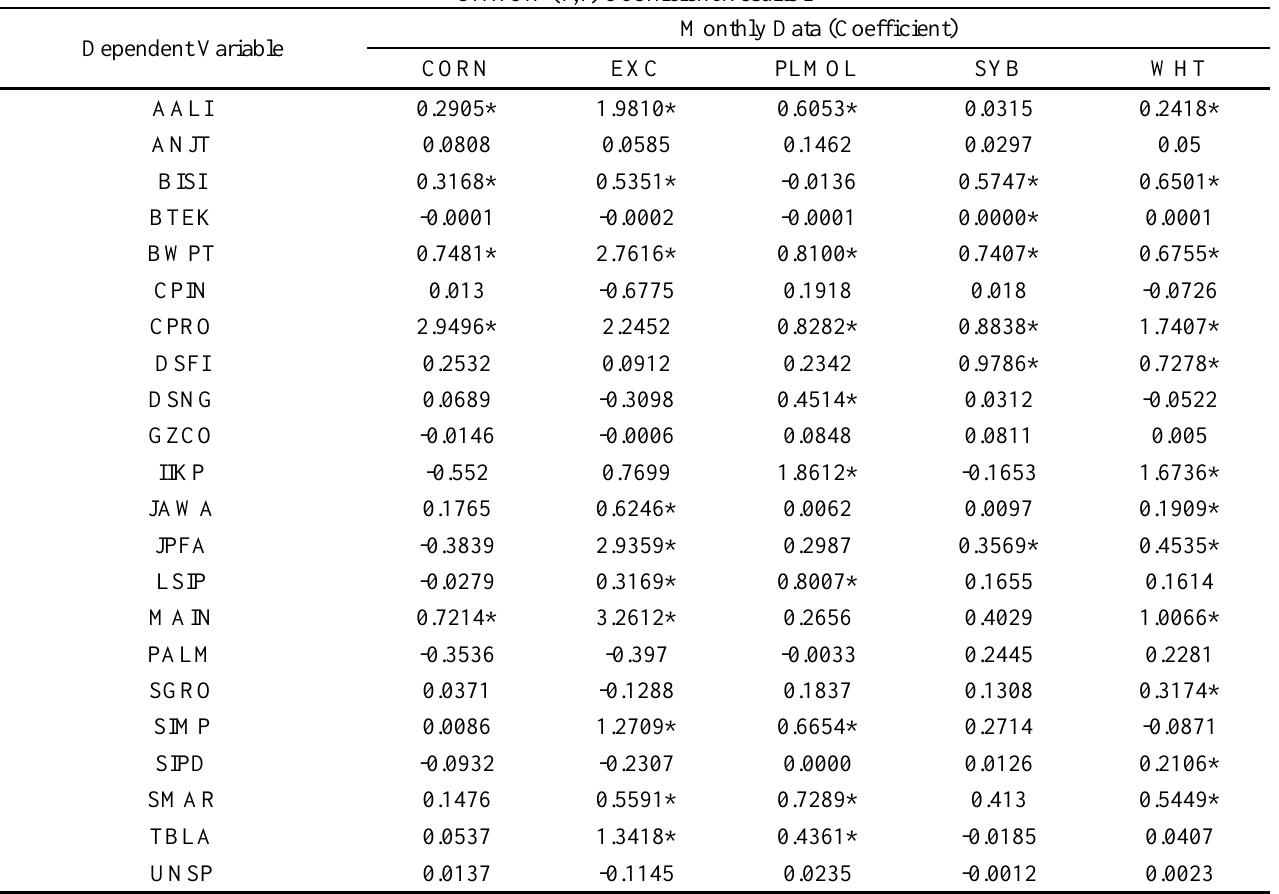
Figure 3: Normal and Leptokurtic